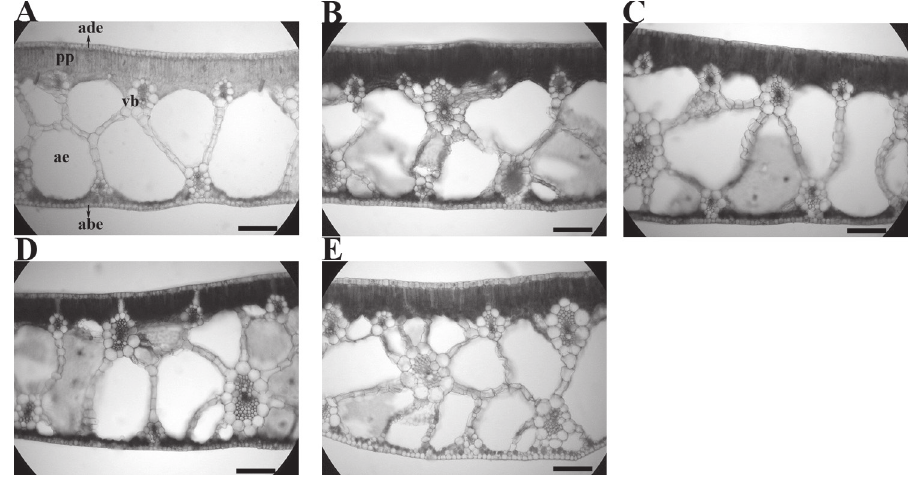
Figure 2 - Leaves anatomical modifications of Eichhornia crassipes grown in nutrient solutions under different lead concentrations. ade= adaxial epidermis, abe = abaxial epidermis, pp = palysade parenchyma, ae = aerenchyma chamber, vb = vascular bundle. A = 0.00 mg L -1 , B= 0.50 mg L -1 , C =